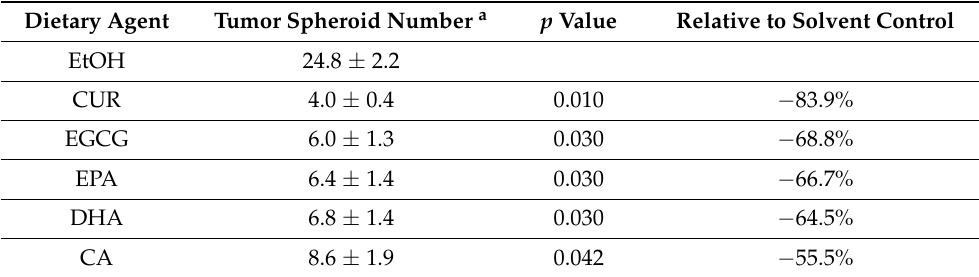
Table 5. Effects of dietary agents on tumor spheroid formation in 850 MIN COL model.